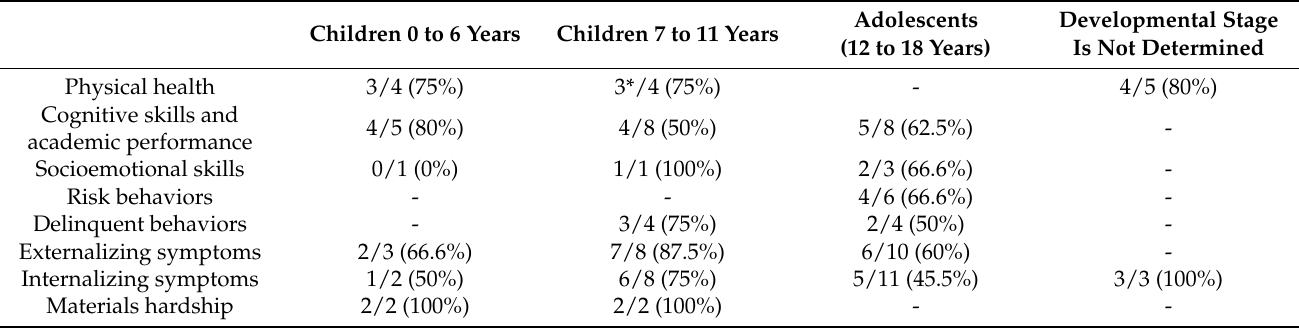
Table 1. Summary of significant direct effects of parental incarceration on the different